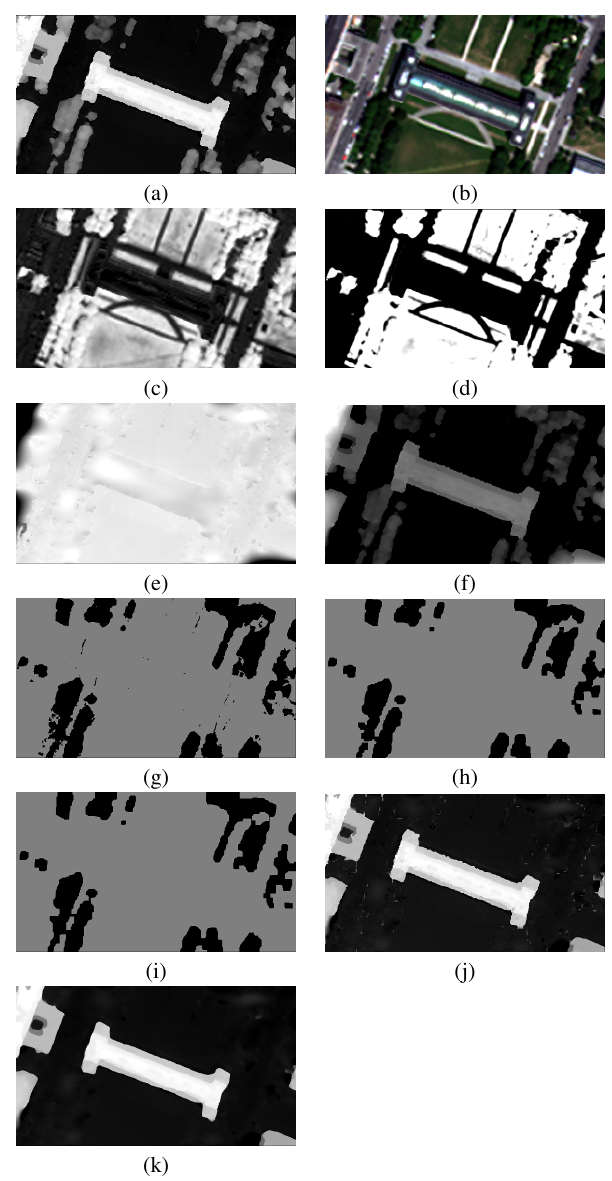
Figure 2. Preprocessing steps, exemplified for Alte Pinakothek in Munich, Germany. A DSM generated from WorldView-2 data (a) and an optical image from WorldView-2 (b) are used as in- put to the preprocessing chain. The NDVI (c) is calculated to do the fuzzy classification (d). A DTM (e) and a nDSM (f) are generated. A binary mask (g) is determined to separate elevated vegetation. Noise in the mask is reduced by the morphological operators closing (h) and opening (i). Image (j) displays the re- placement of the height values and (k) the final DSM after noise